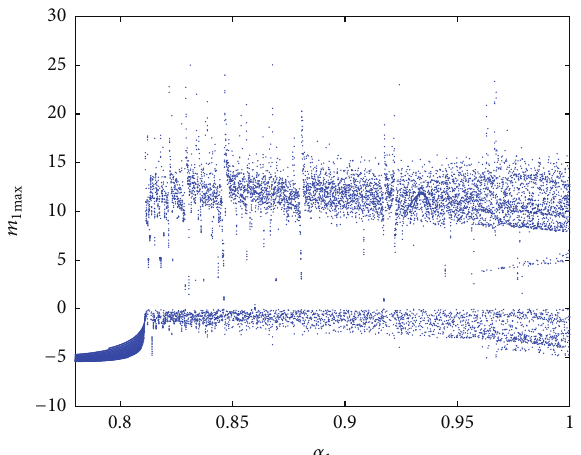
Figure 5: Bifurcation diagram of system (5) with 𝛼 1 ∈ [0.78, 1] .